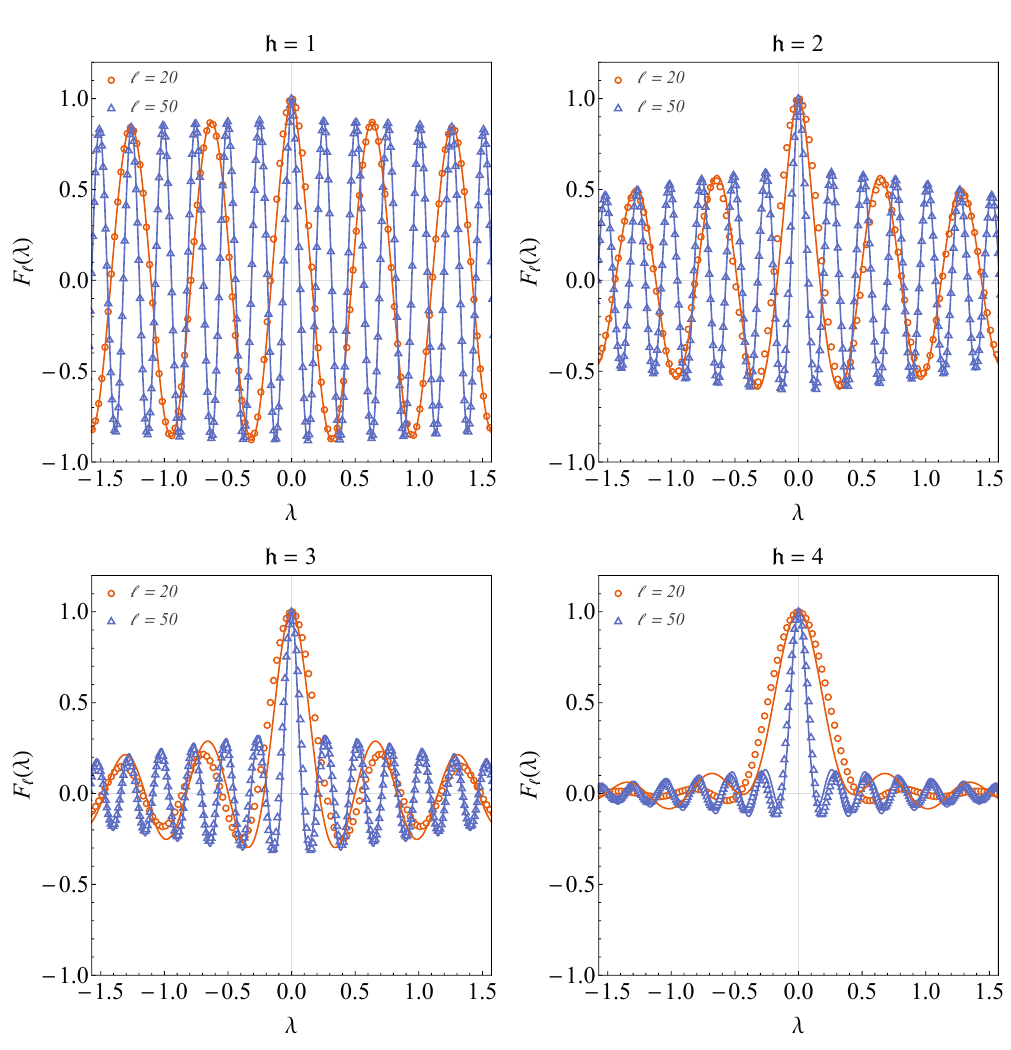
Figure 11: The exact stationary generating function in Eq. (48) (symbols) is com- pared with the scaling behaviour (82) (full lines) for different values of the rescaled parameter h = { 1, 2, 3, 4 } which corresponds to scaling value of the parameter γ = exp ( − h 2 / 8 ) (cid:39) { 0.8825, 0.6065, 0.3246, 0.1353 } . For clarity reason here we plot only the region λ ∈ [ − π/ 2, π/ 2 ] . Notice that in these plots we did not adjusted any parameter by